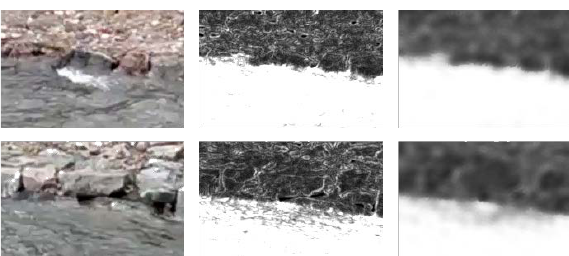
Figure 6: Detail view of wavy and shadowed areas: Single frame, spatio-temporal texture before and after bilateral filtering (left to right)